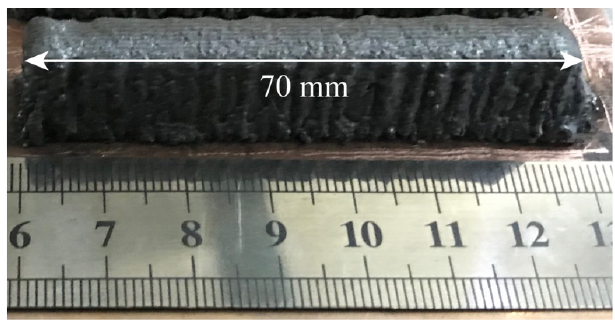
Figure 15. Morphology of the bulk specimen.